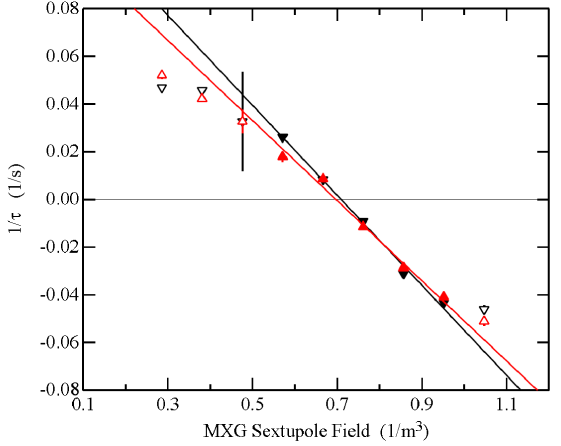
FIG. 20. Measurements made with the long beam of 1 / τ as a function of the S sextupole field (Scan 2). The G field is zero. The optimum field value is indicated by a dashed